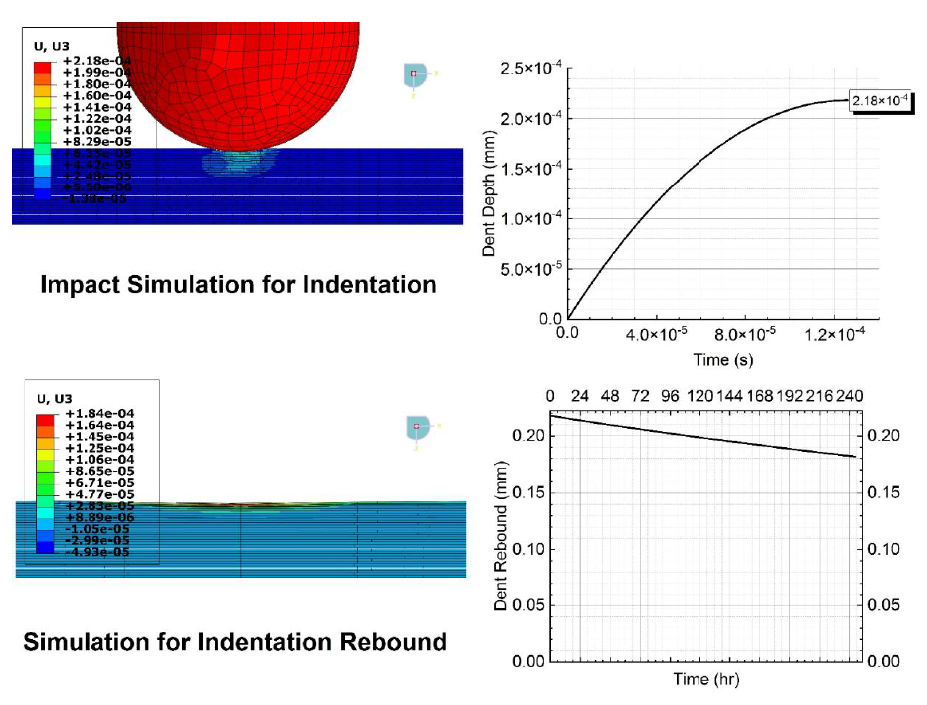
Figure 15. Case II: 40 J.